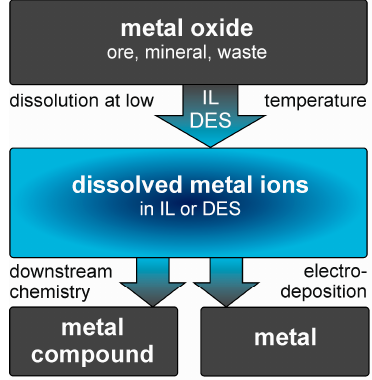
Figure 2. Scheme of the general idea of metal oxide processing in ILs and DESs.